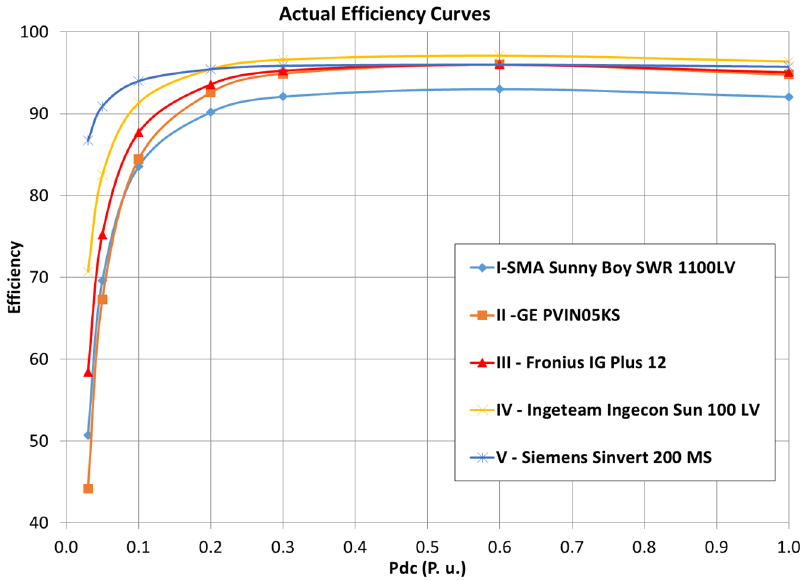
Figure 4. Typical per unit efficiency curves for grid-connected solar